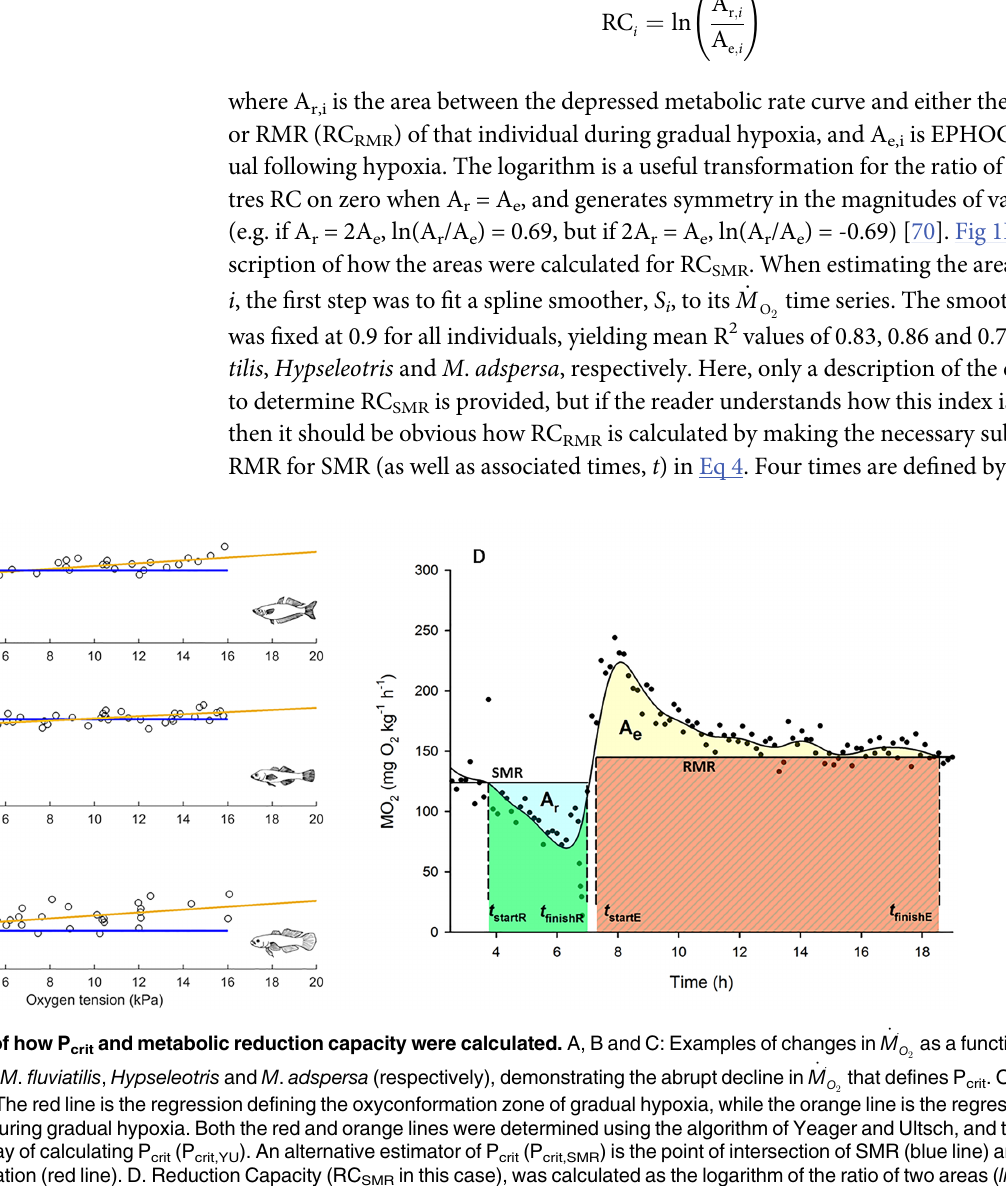
Fig 1. Illustrations of how P crit and metabolic reduction capacity were calculated. A, B and C: Examples of changes in tension for individual M . fluviatilis , Hypseleotris and M . adspersa (respectively), demonstrating the abrupt decline in lines are presented. The red line is the regression defining the oxyconformation zone of gradual hypoxia, while the orange line is the regression defining the oxyregulation zone during gradual hypoxia. Both the red and orange lines were determined using the algorithm of Yeager and Ultsch, and their point of intersection is one way of calculating P crit (P crit,YU ). An alternative estimator of P crit (P crit,SMR ) is the point of intersection of SMR (blue line) and the regression defining oxyconformation (red line). D. Reduction Capacity (RC SMR in this case), was calculated as the logarithm of the ratio of two areas ( ln (A r /A e )), where A r is the area between the SMR and depressed metabolic rate curves, during gradual hypoxia, and A e is excess post-hypoxic oxygen consumption (EPHOC). Two points of intersection between the SMR curve and the fitted spline curve, and two points of intersection between the RMR curve and the spline, define four times critical for determination of the integrals defining A r and A e : t startR , t finishR t startE and t finishE are, respectively, the times at which (a) metabolic reduction below SMR began; (b) metabolic reduction ceases; (c) EPHOC begins; (d) EPHOC finishes (see Materials and Methods). (Data presented in D is from a 4.67 g M . fluviatilis